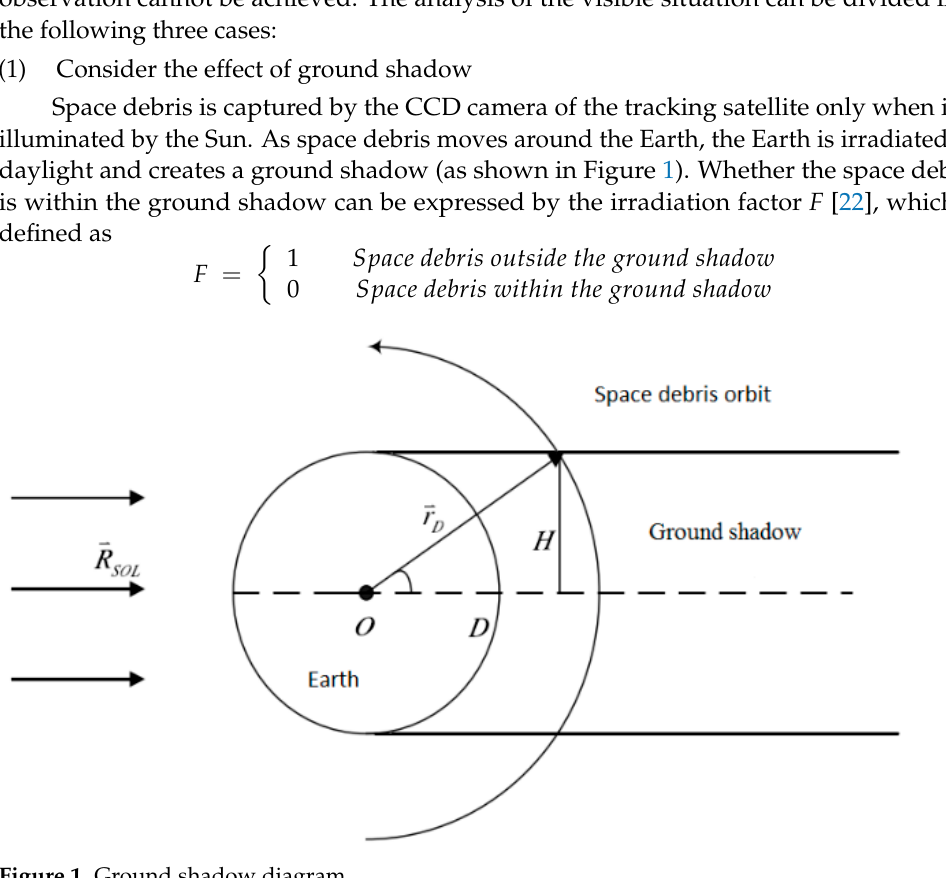
Figure 1. Ground shadow diagram.